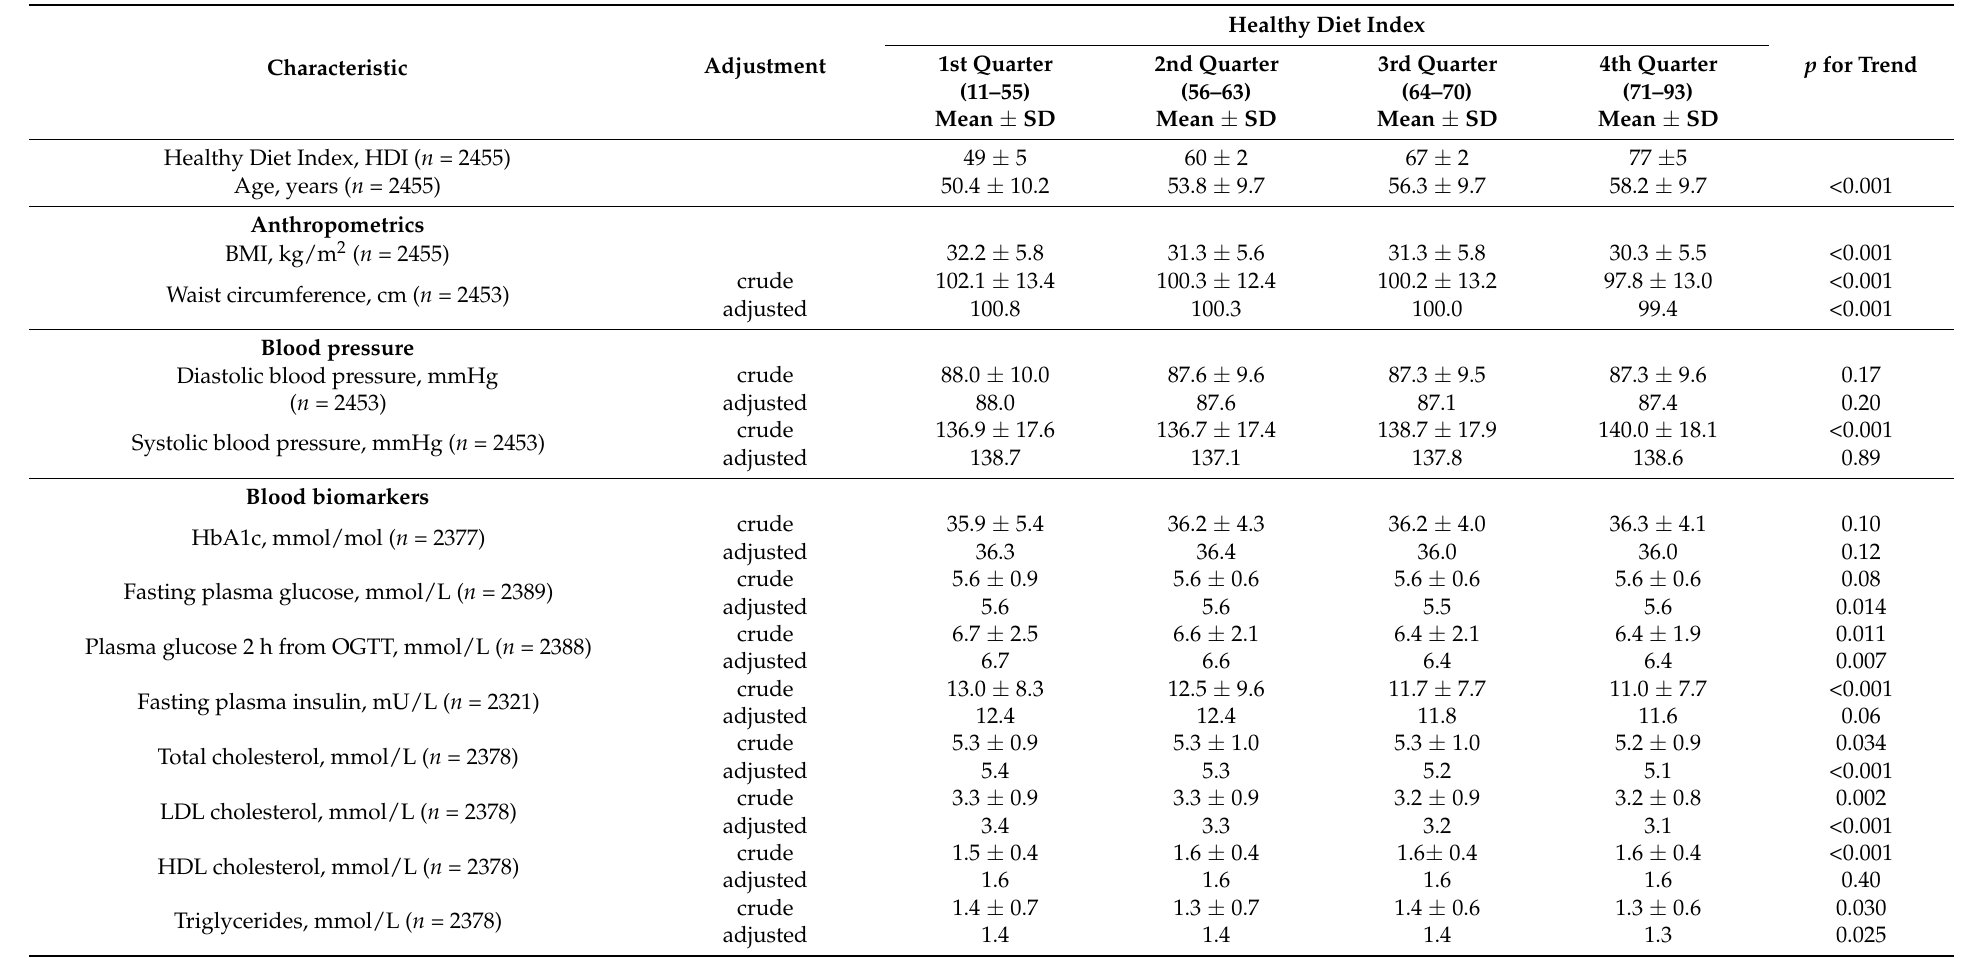
Table 3. Association between Healthy Diet Index (HDI) and age, anthropometrics, blood pressure, and biomarkers (crude and age- and BMI-adjusted) among women in StopDia data.